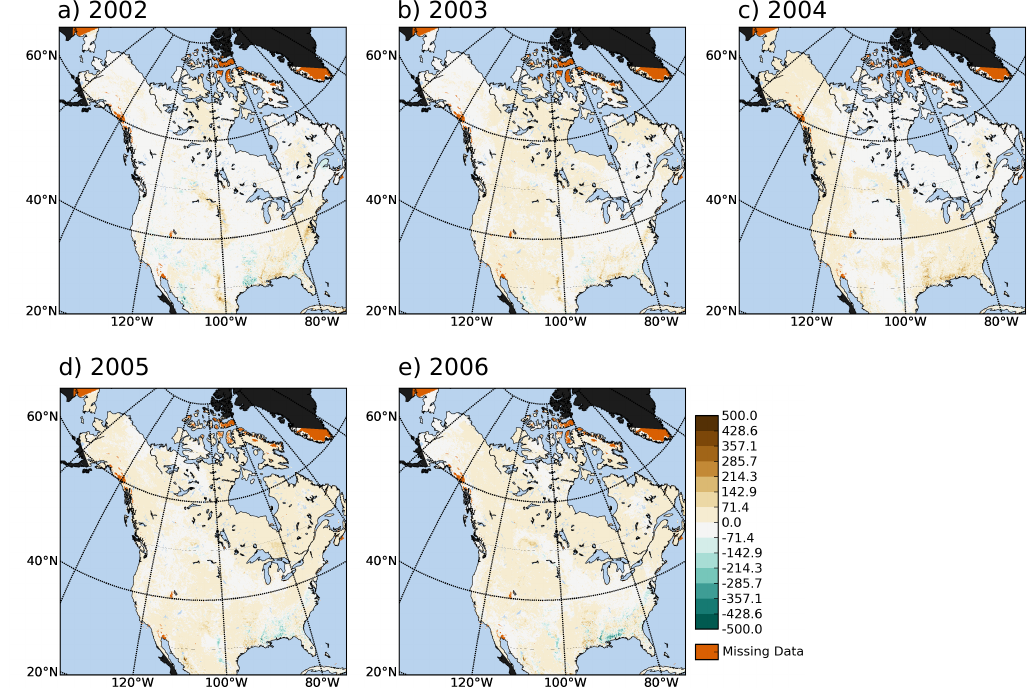
Fig. 11. Annual anomaly, annual integrated VPRM respiration, calculated using PFT–all-data VPRM parameters. Units are gCm − 2 yr − 1 . Anomalies are calculated as annual integrated VPRM R minus the 2002–2006 mean annual integrated VPRM R . Thus negative values denote greater than average atmosphere to ecosystem CO 2 flux. Black areas are outside of the study